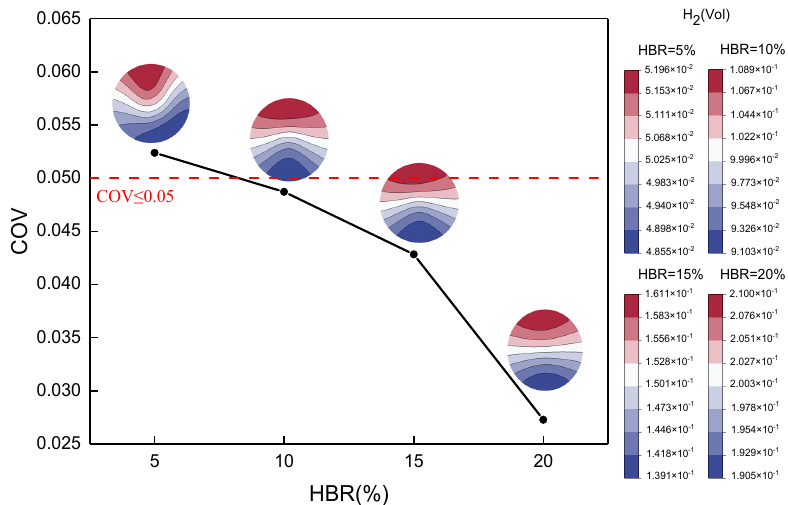
Figure 10. COV at the flow distance of z = 40 D (40th cross section) under different HBRs.